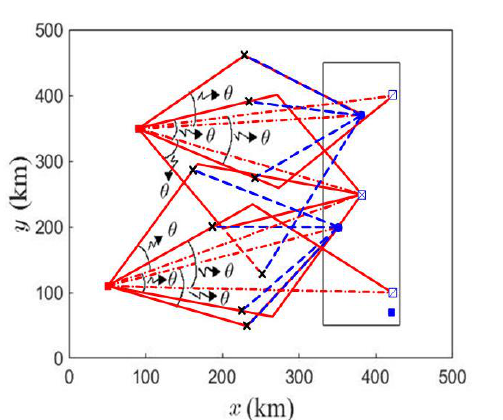
Figure 2. Exemplary scenario of route planning, square with cross: major post, square with slash: minor post, blue square: defense station, red square: attack station, ———: planned attacker path, × : anticipated intercept point, − − − : anticipated attacker path, − − − : anticipated interceptor path, − · − : target assignment of attack station, rectangular frame: deployment area of defense